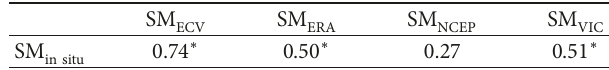
Table 1: The correlation coefficients between SM in situ and SM ECV , SM ERA , SM NCEP , and SM VIC data, respectively, which are computed from the annual time series shown in Figure 6. The asterisk indicates thatthecorrelationcoefficientpassesthesignificancetestat5%level.